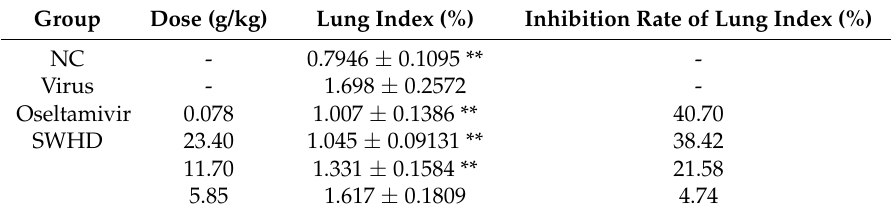
Table 2. Detection of effect of SWHD on the lung index of infected mice.